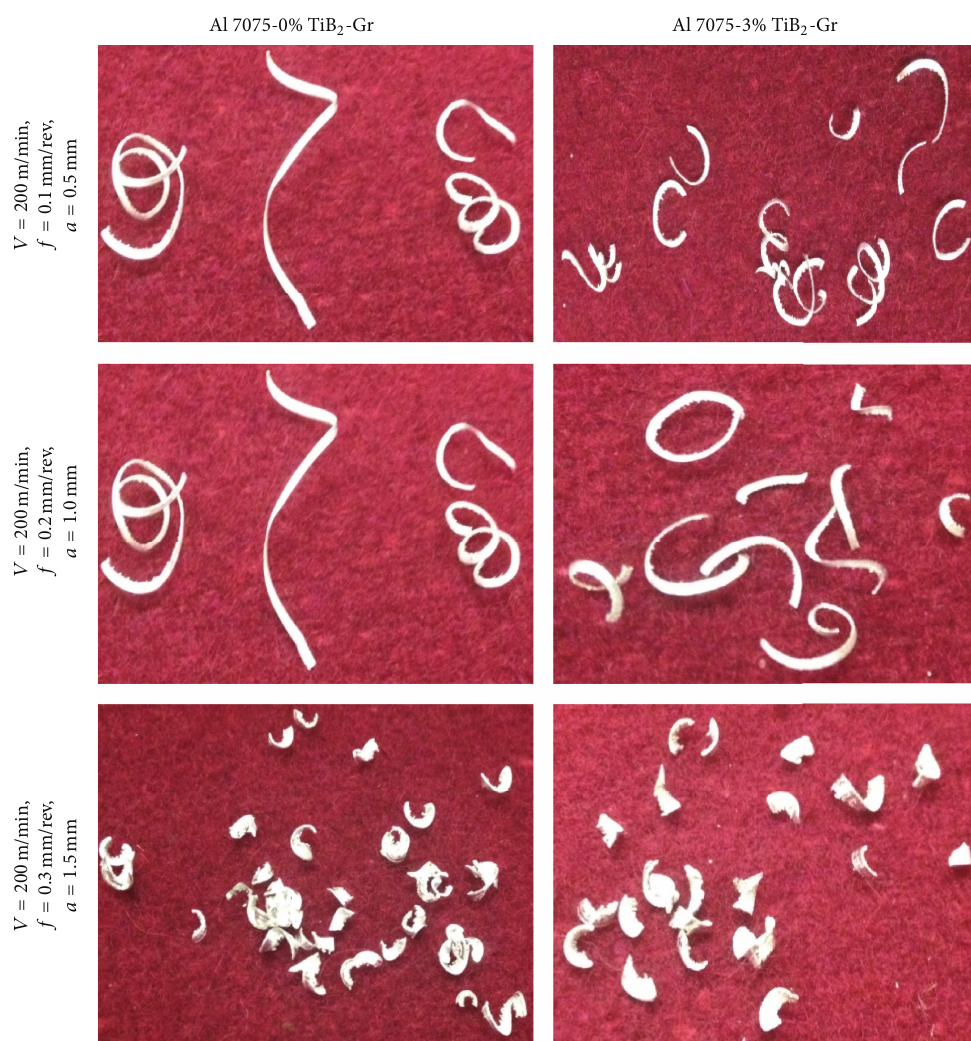
Figure 13: Examination of chip morphology with selected cutting parameters of Al 7075-3% TiB 2 -0% Gr and Al 7075-3% TiB 2 -1% Gr hybrid in situ composite with the cutting tool of 0.4 nose radius insert.